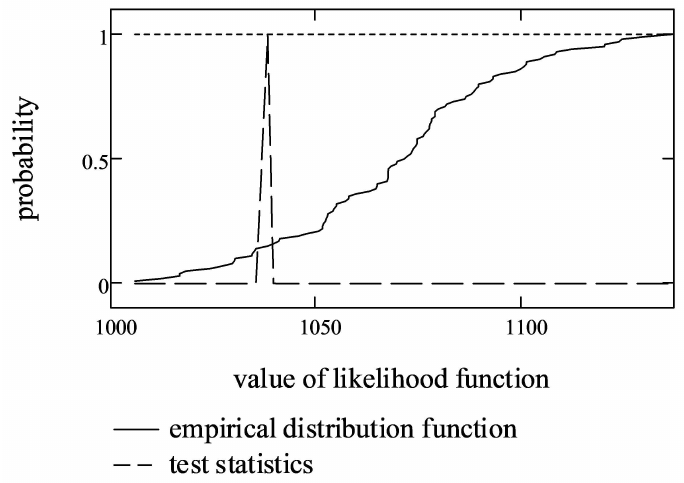
Figure 7. The empirical distribution function of LLF and test statistics of AIS